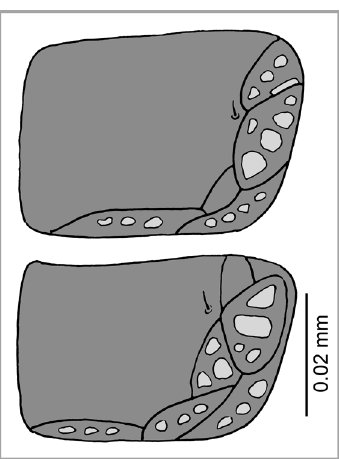
Fig. 7. Adelges (Dreyfusia) merkeri (Eichhorn, 1957). First instar hibernating fundatrix, spinal plates on meso- and metathorax (left side), showing arangement of wax gland pits (after Eichhorn 1956,